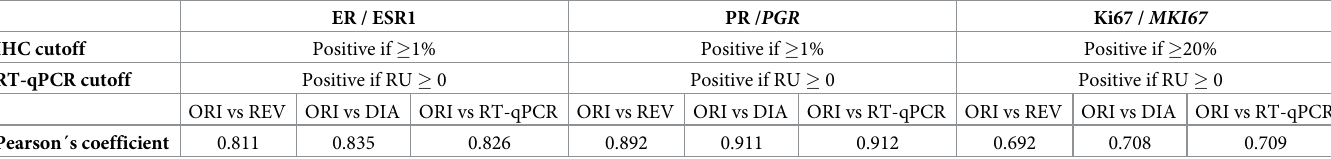
Table 4. Agreement within IHC (ORI versus REV, ORI versus DIA) and between IHC (ORI) and